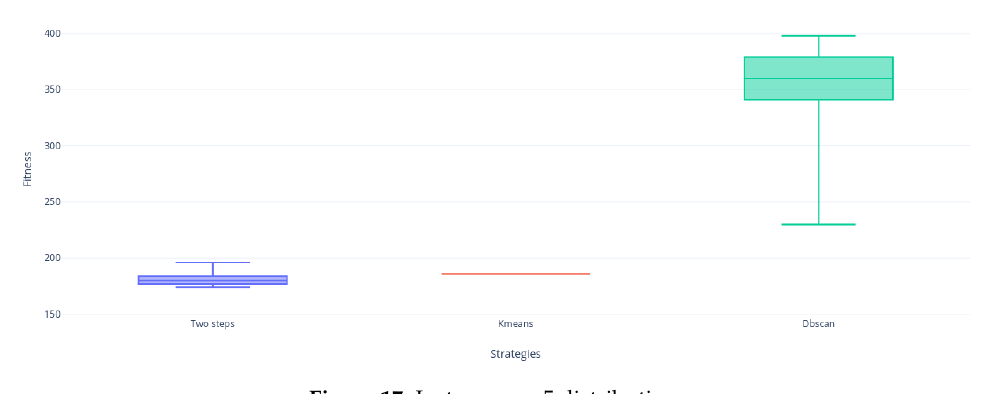
Figure 17. Instance nrg.5 distribution.